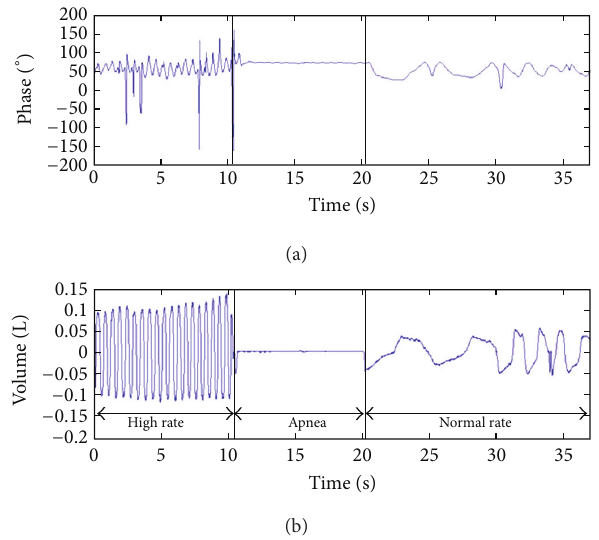
Figure 5: Comparison of the 𝑆 11 phase signal (a) and spirometer signal (b) subject sitting, distance 𝐷 = 20cm.